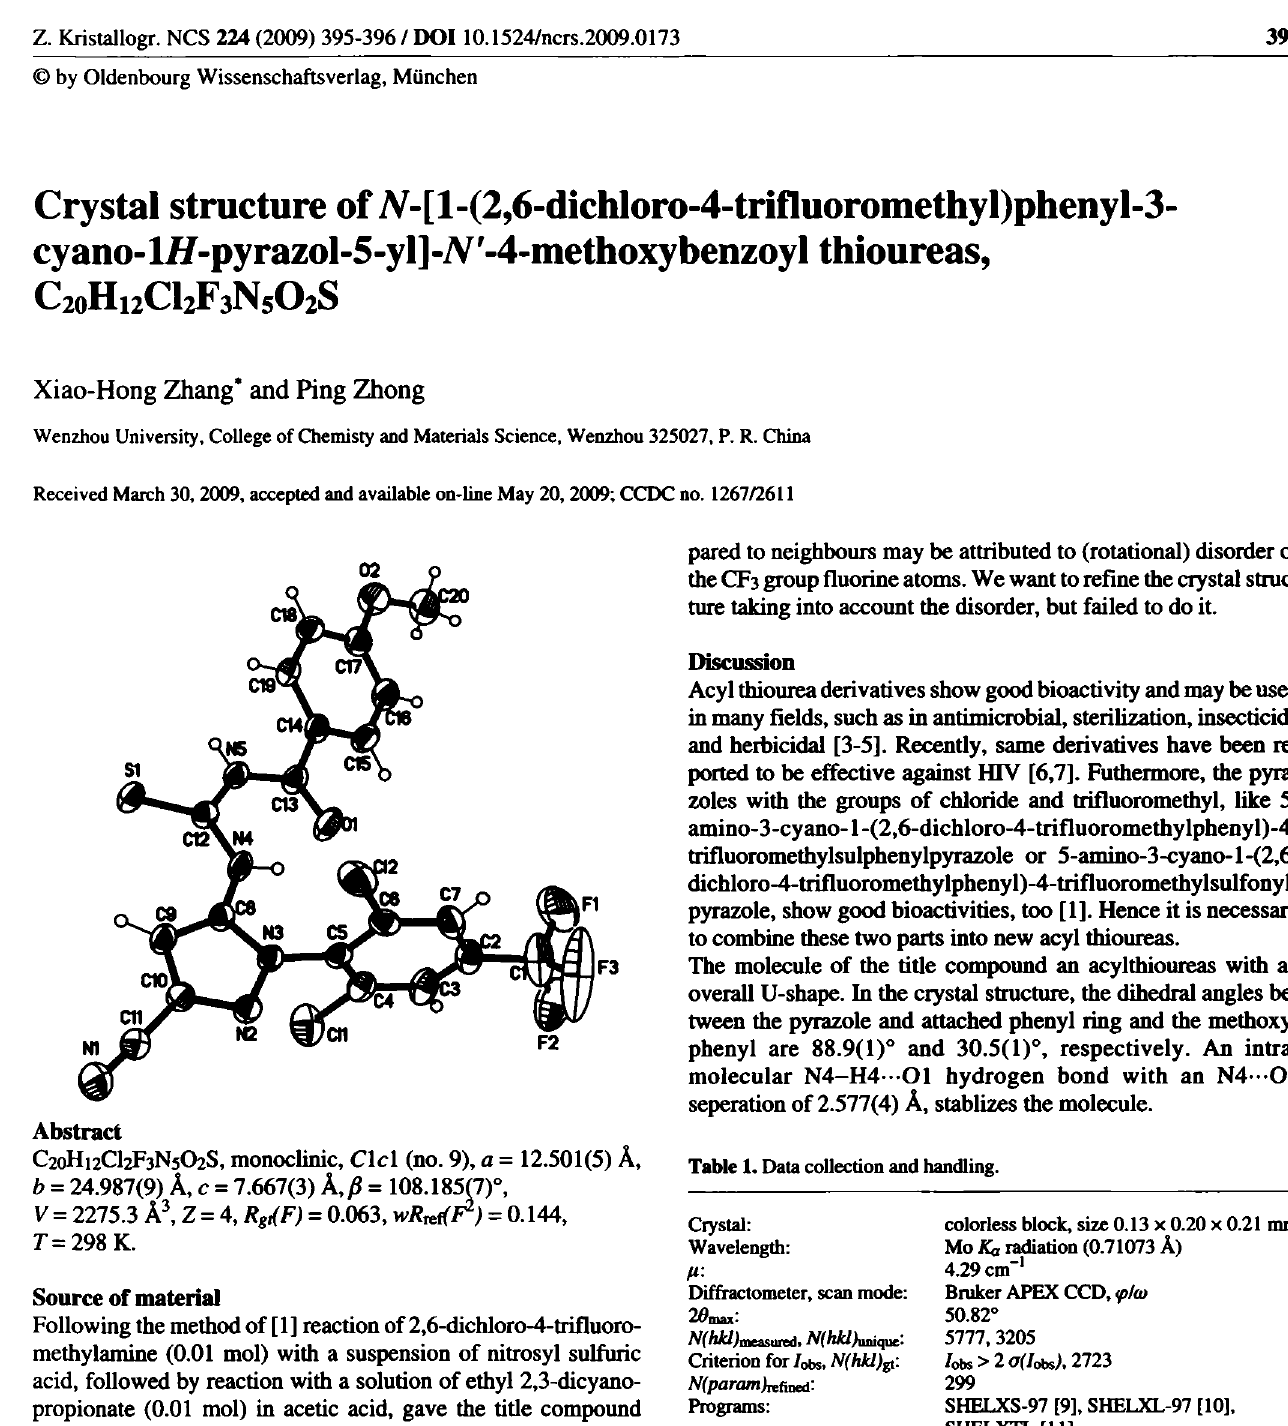
Table 2. Atomic coordinates and displacement parameters (in Â 2